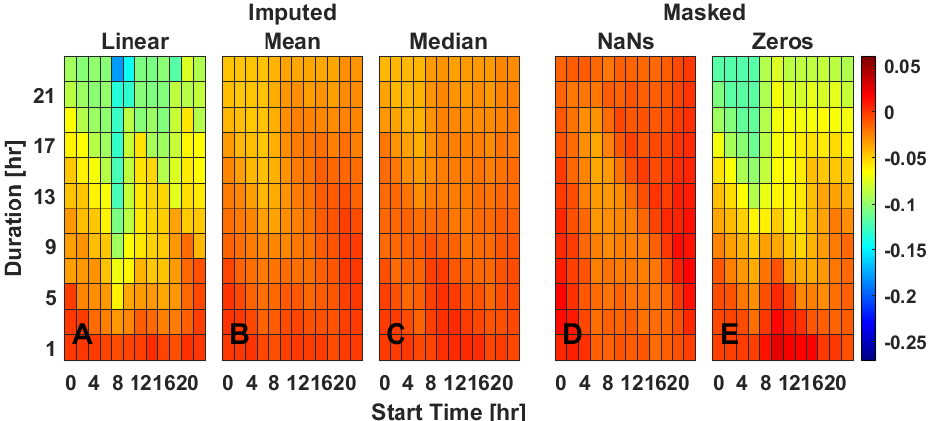
Figure 2. Rhythm fragmentation (IV) for a single missing data gap starting on a representative day (Tuesday). Data are the mean difference between the masked and true IV values ( D , E ) or imputed and true IV values ( A – C ) as extracted from Bland–Altman plots. Three different imputation methods [linear interpolation ( A ), mean ToD ( B ), median ToD ( C )] and two masking methods [NaNs ( D ), zeros ( E )] are presented for varied durations (y-axis) and timing (x-axis) of masked data gaps. Values are color-coded as indicated with best performance being closer to 0. For heat maps of each individual day of rhythm fragmentation, see Supplemental Data Figure S5.